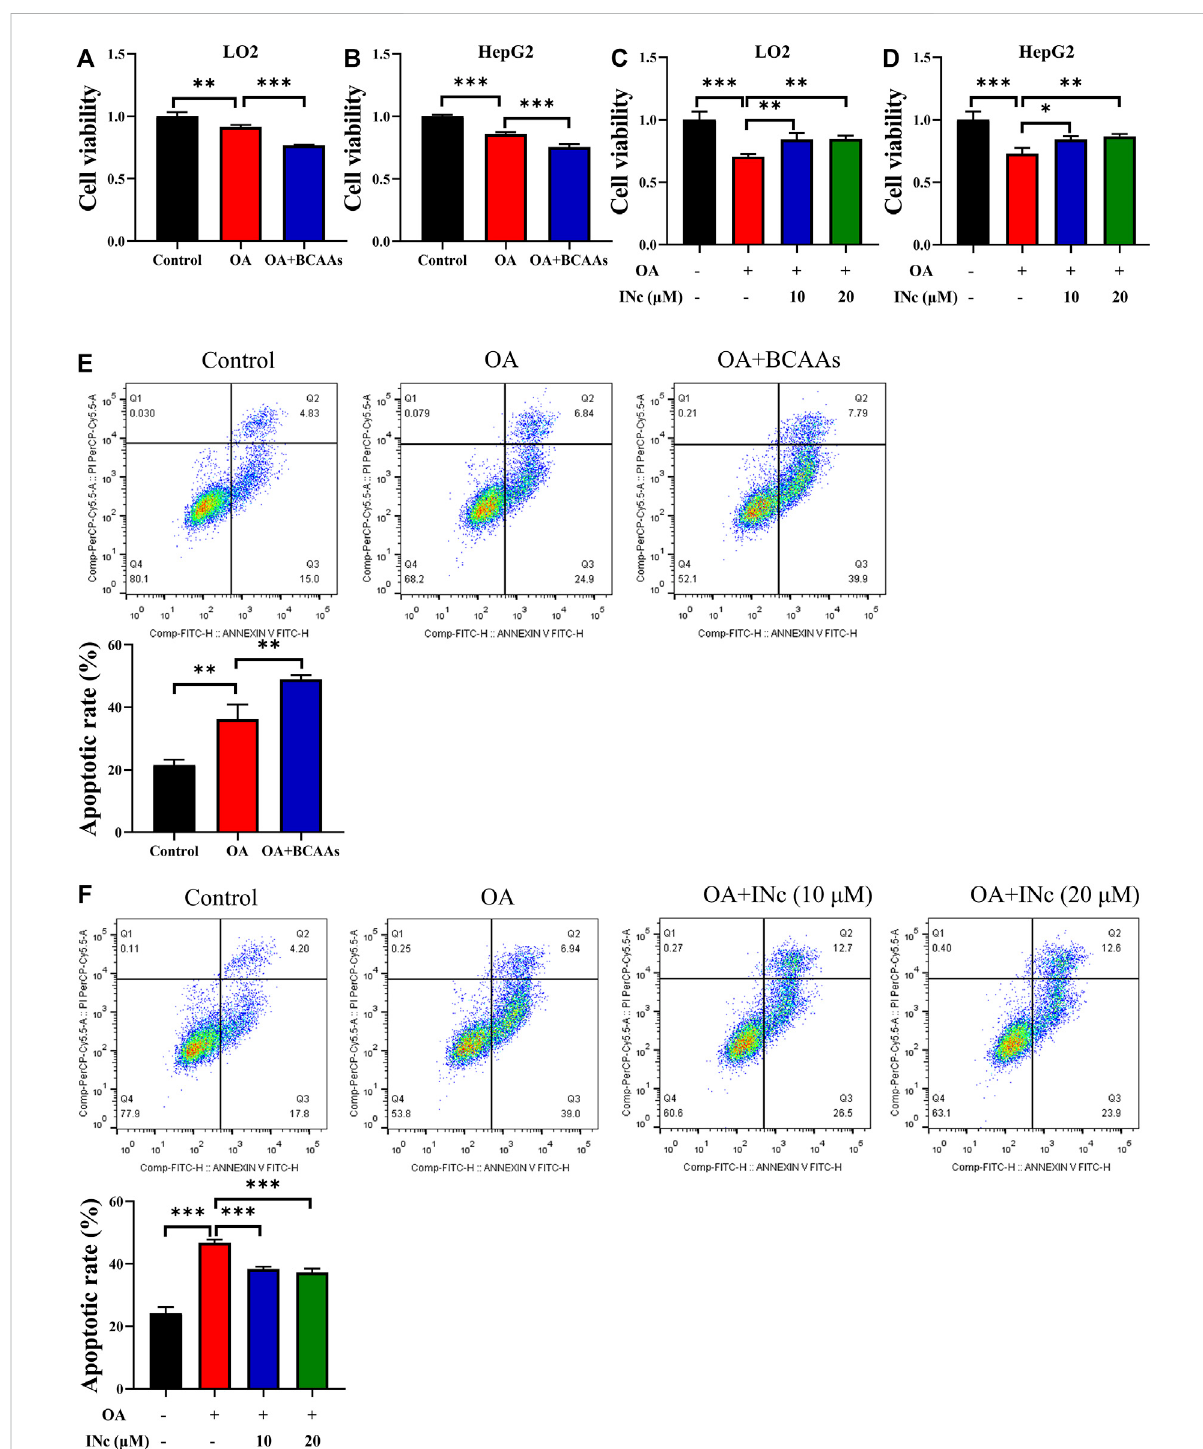
BCATc Inhibitor 2 alleviates OA-induced cell apoptosis. (A,B) LO2 and HepG2 cells were incubated with 0.5 mm Oleic acid with or without 10 mm BCAAs for 48 h. Cell viability was detected by MTT assay. (C,D) LO2 and HepG2 cells were incubated with 0.5 mm Oleic acid in the presence 0, 10, 20 µM BCAT-IN-2 for 48 h. Cell viability was detected by MTT assay. (E) LO2 cells were incubated with 0.5 mm Oleic acid with or without 10 mm BCAAs for 48 h. Apoptotic cell rate was determined by Annexin V/PI staining and cytometry based on Q2+Q3. (F) LO2 cells